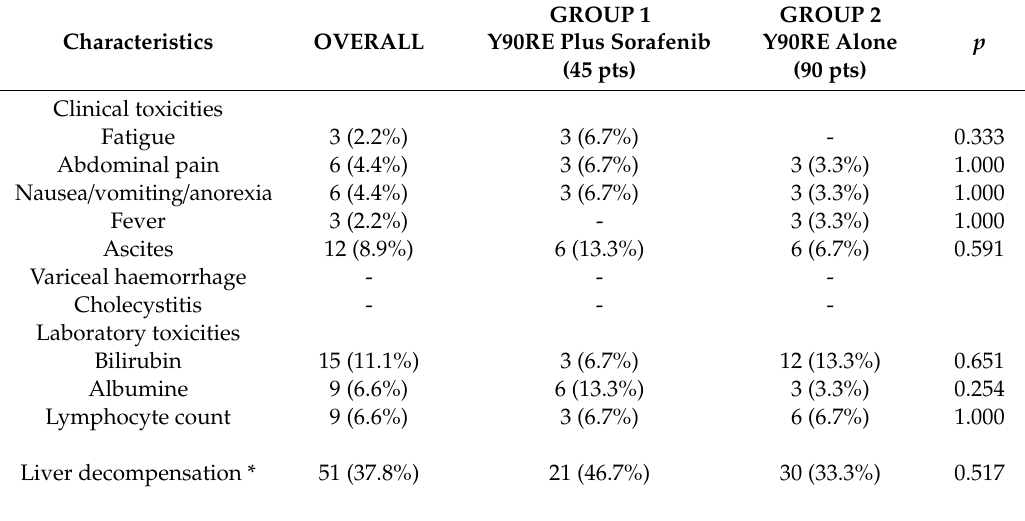
Table 2. Cumulative toxicity analyses. Only grade 3–4 clinical and laboratory toxicities (CTCAE v. 5.0) recorded at 3 months are